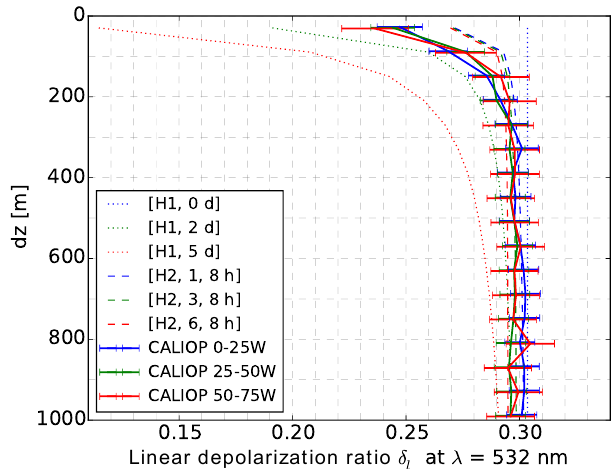
Figure 10. Linear depolarization ratio δ l profiles at λ = 532nm in the upper 1km of the SAL. CALIOP profiles averaged over profiles from summer months 2007 to 2011 that fulfill conditions listed in the text are shown as solid blue, green, and red lines. The colors de- note different longitude ranges. Error bars of the CALIOP profiles show the estimated statistical uncertainty (cid:49)δ l of the average δ l . For comparison model results for both hypotheses are also shown as dotted (H1) and dashed (H2)